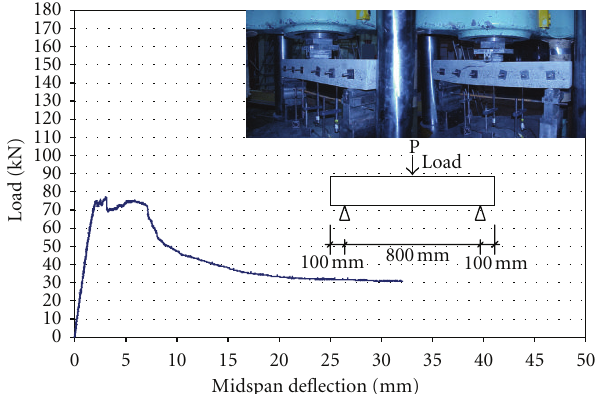
Figure 10: Load versus midspan deflection of control RC beam